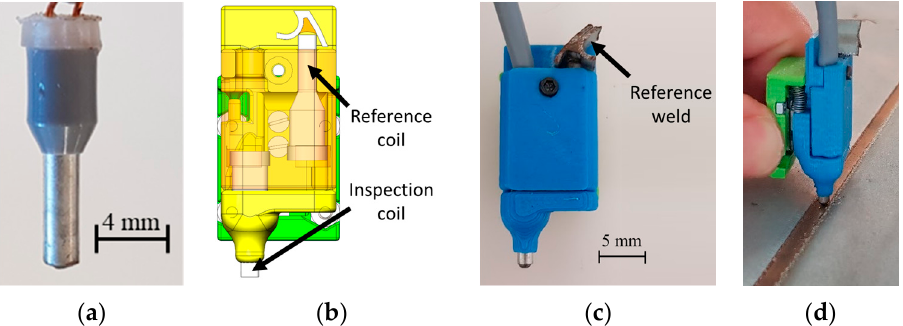
Figure 11. Tailored EC probes. ( a ) Encapsulated EC individual bobbin; ( b ) EC probe CAD represen- tation; ( c ) probe with two bobbins which operate in bridge differential mode; ( d ) device over the welded joint coupled with a spring-loaded linear bearing for a constant lift-off.